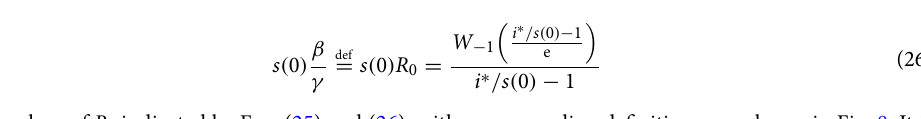
θ Figure 9. Distributions F of the dimensionless infectious period θ/ D with average 1. The curves shown D (cid:30) (cid:31) imply that the newly infected are removed from the infectious compartment, I, according to the formulas shown (cf. Fig. 5). All distributions have the same average equal to 1, as also indicated by the shaded